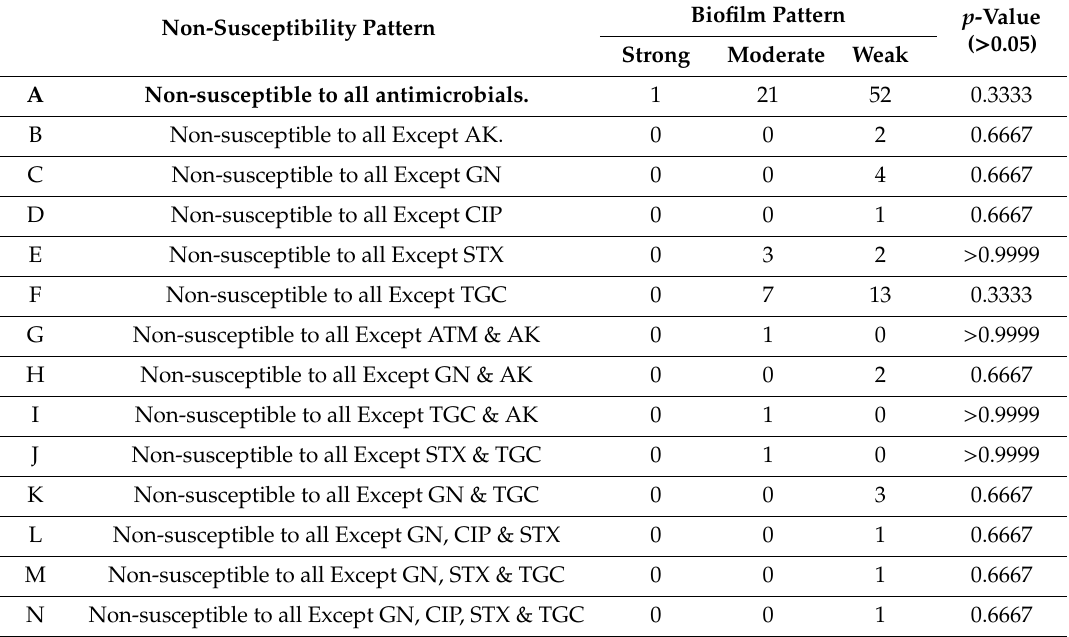
Table 2. Correlation between non-susceptibility pattern and biofilm